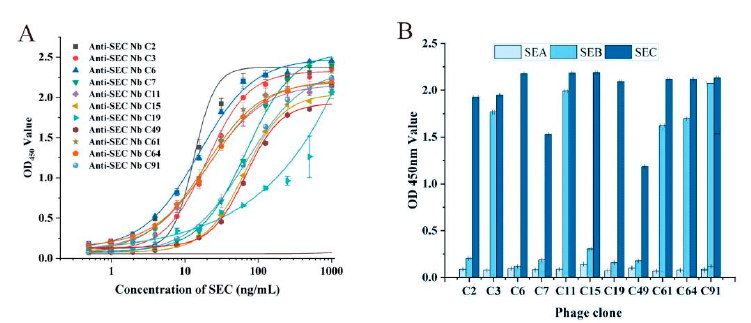
Figure 3. Binding activity and specific analysis of the anti-SEC Nbs. ( A ) Binding activity analysis of the phage display Nbs with SEC via phage-ELISA. ( B ) Specific analysis of the phage display Nbs with SEC via